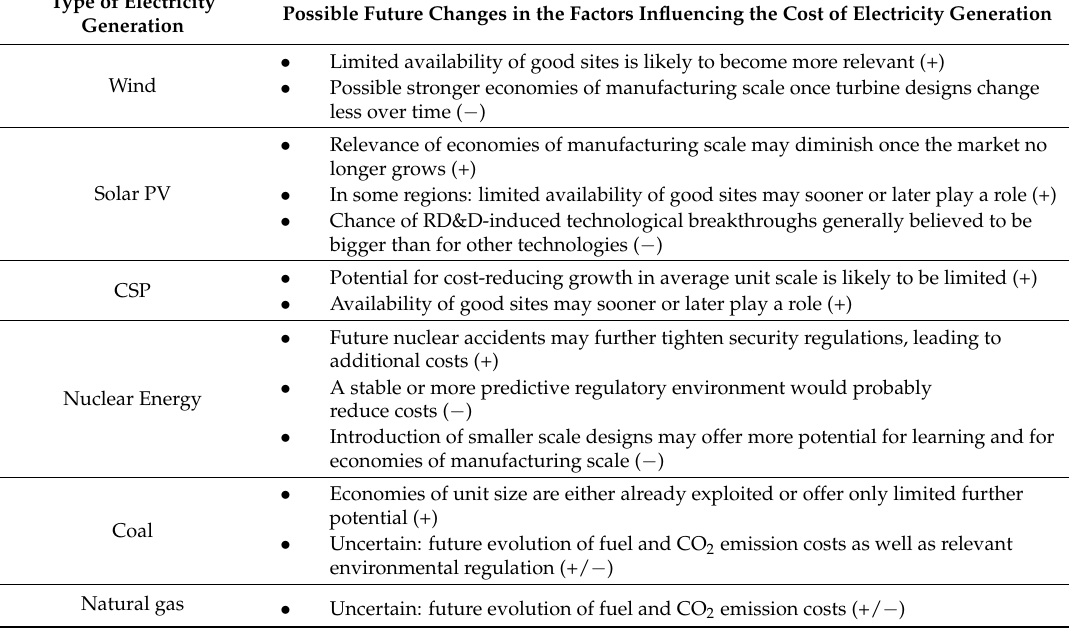
Table 3. Possible future changes in the factors influencing the cost of electricity generation technologies. Type of Electricity